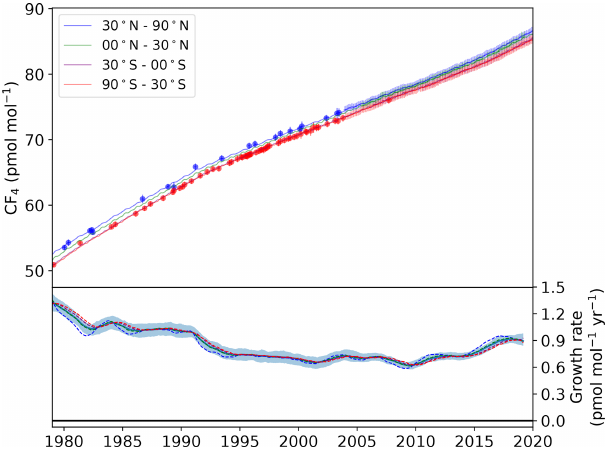
Figure 2. Modelled semi-hemispheric monthly average CF 4 mole fractions (30–90 ◦ N: blue; 0–30 ◦ N: green; 30–0 ◦ S: purple; 90– 30 ◦ S: red). Monthly averaged baseline observations are shown as data points with 1 σ error bars. The more sparse filled circles rep- resent northern (blue) and southern (red) hemispheric air archive samples. The solid trend lines were calculated using the AGAGE 12-box model with emissions from the inversion as input. The lower plot shows the model-derived mole fraction growth rate, smoothed with an approximate 1-year filter, for each semi-hemisphere (dashed lines) and the global mean with 1 σ uncertainty (solid line and shad-